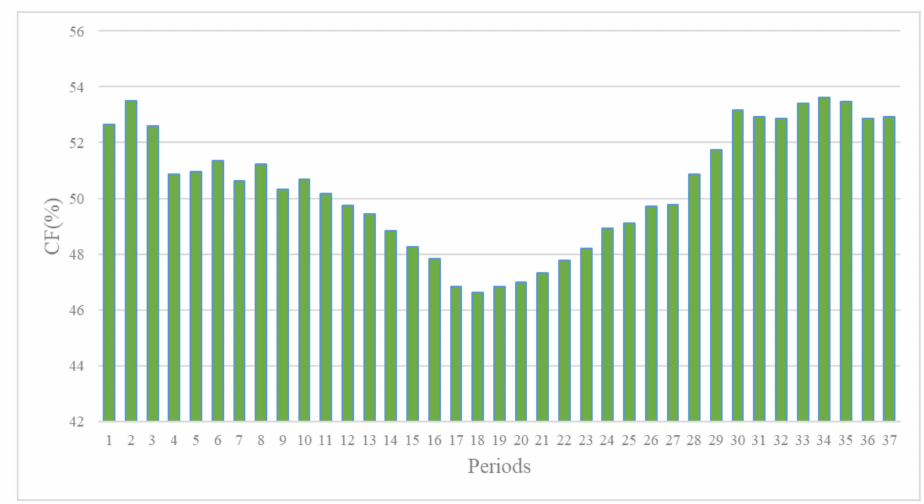
Figure 6. The global land average cloud frequency of GLHCC over 37 time periods (%).